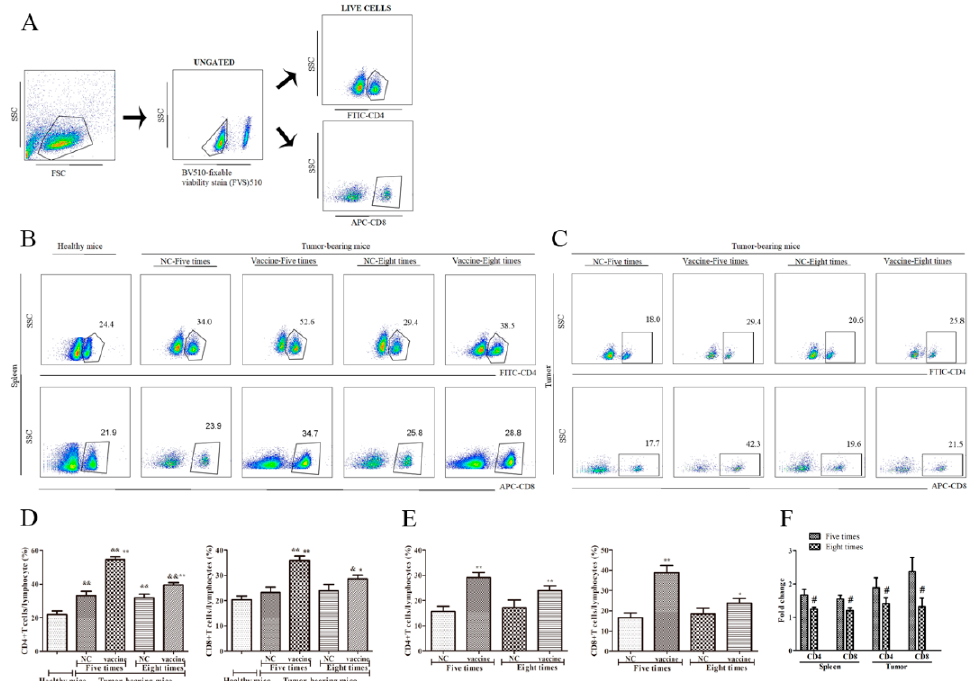
Figure 3. The e ff ect of immunization cycles on recombinant MUC1-MBP vaccine-induced CD4 + and CD8 + T cells in the spleen and the tumor microenvironment. ( A – E ) Mice were euthanized 15 days after tumor inoculation and the splenic mononuclear cells from each group were stimulated in vitro with a cocktail (2 µ L / mL) for 5 h. Then, the cells were incubated with BV510-conjugated anti-fixable viability stain 510, FITC-conjugated anti-CD4, and APC-conjugated anti-CD8. ( A ) Dot plots showing the gating strategy. ( B , C ) The percentages of CD4 + and CD8 + T cells in the spleen and the tumor microenvironment are shown in the dot plots of the flow cytometry data. ( D , E ) The percentages of CD4 + and CD8 + T cells in the spleen and the tumor microenvironment are shown in the data table. ( F ) Fold change (CF) represents the ratio of the experimental group to the NC group. Increased fold change = the experimental group / NC group. & p < 0.05, && p < 0.01 vs. healthy mice. * p < 0.05, ** p < 0.01 vs. the NC group. # p < 0.05 vs. the groups immunized five